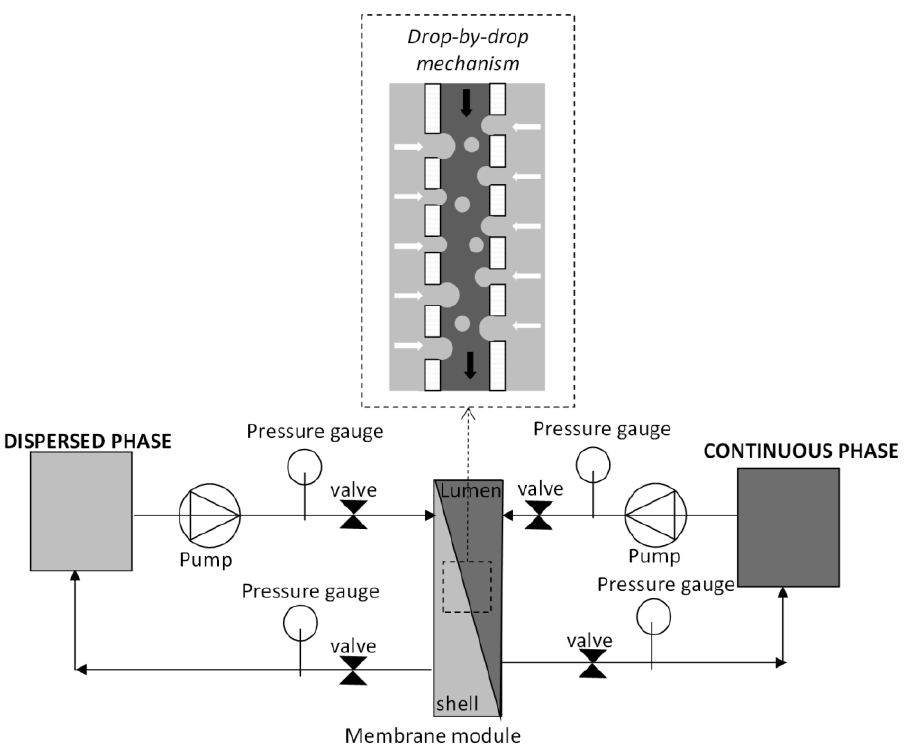
Figure 1. Crossflow membrane emulsification equipment and schematic representation of emulsion droplet formation at the membrane pore.